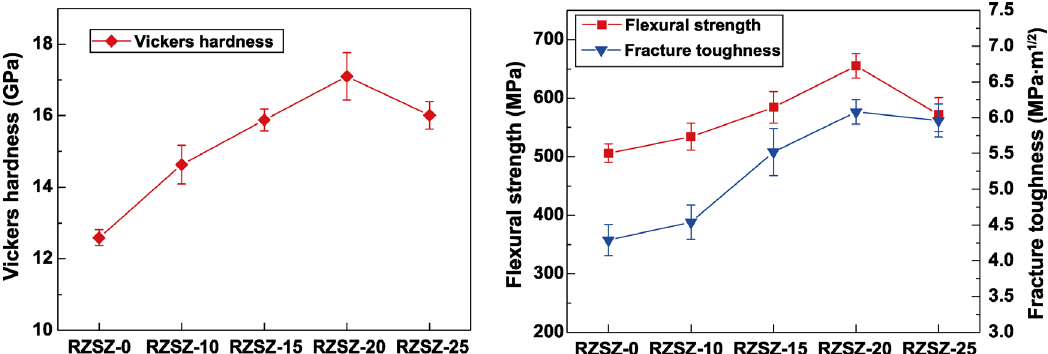
Fig. 7 Vickers hardness, flexural strength, and fracture toughness of the ZrB 2 –SiC based composites prepared by reactive hot